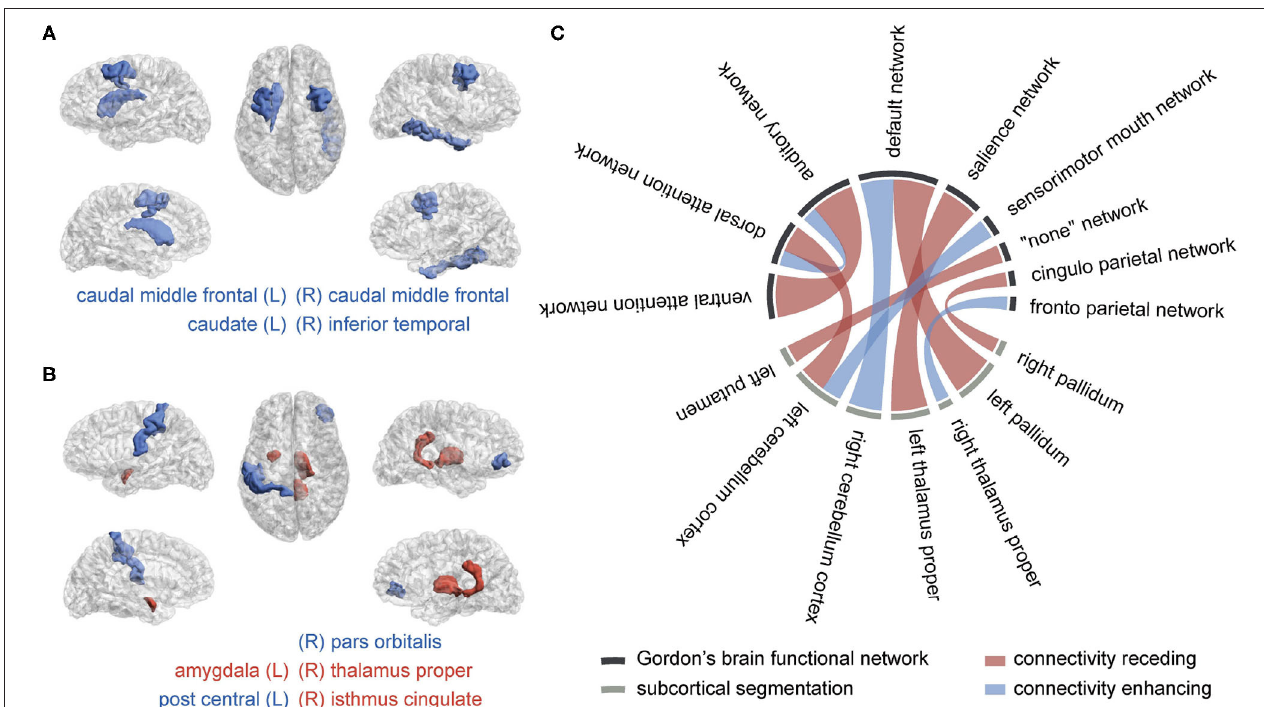
FIGURE 3 | The brain regions and connectivity associated with attention-deficit/hyperactivity disorder (ADHD). (A) Macrostructural abnormal regions, (B) microstructural abnormal regions, and (C) abnormal functional connectivity The blue color represents a lessened measure in the ADHD group, while the red color represents a strengthened one. The more frequently they are picked in the selection procedure, the wider their bonds